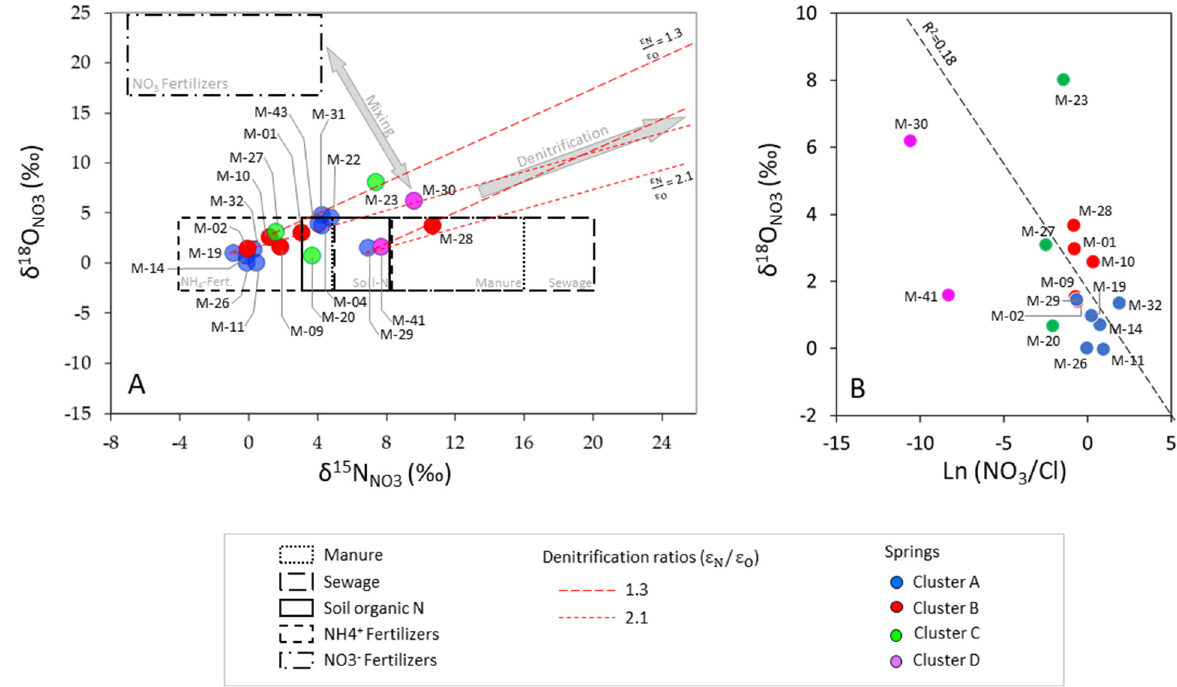
Figure 12. ( A ) Dual isotope scatterplot using δ 18 O NO3 and δ 15 N NO3 . The area of nitrates is derived from (1) NO 3 -fertilizers and (2) NH 4 -fertilizers [103]; (3) Soil organic N [116]; (4) Manure [103]; (5) Sewage [116]. The long and short dashed red lines define the isotopic fractionation range ( ε 15 S/ ε 18 O NO3 ) in denitrification reactions, varying between 1.3 [117] and 2.1 [118] , respectively. ( B ) Scatterplot of δ 18 O NO3 values against ln(NO 3 /Cl).